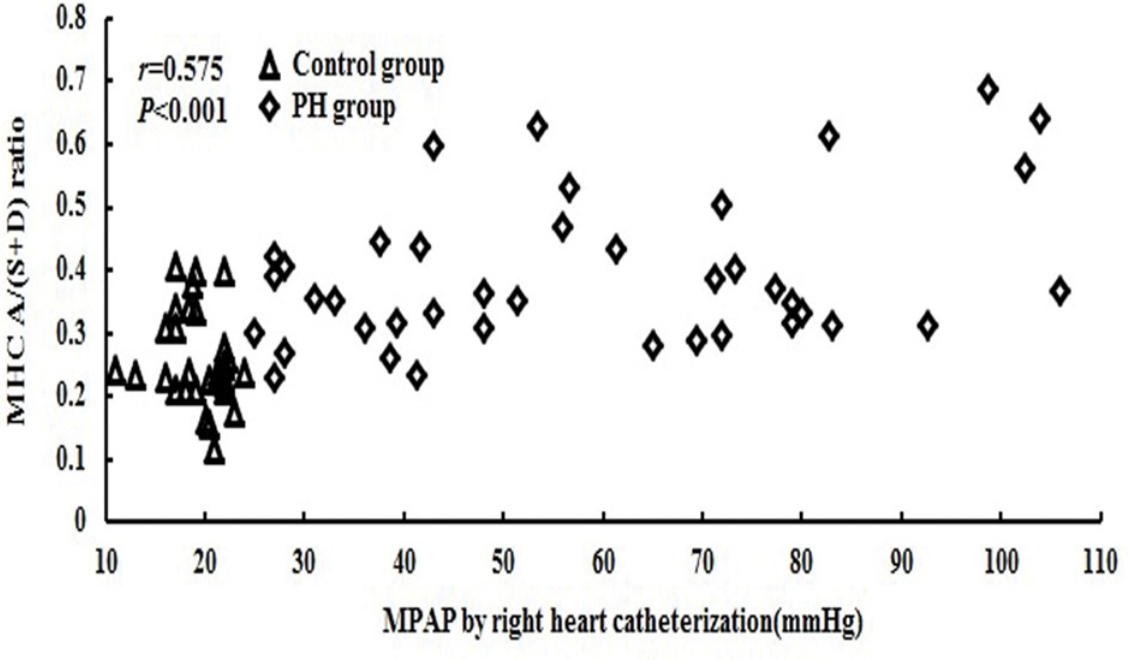
Fig 5. Correlation of the MHV A/(S+D) ratio with invasive MPAP. There was a significant correlation between MPAP and A/(S+D) ( r = 0.575, P < 0.001). (S, systolic peak flow velocity; D, diastolic peak flow velocity; A, atrial reverse peak flow